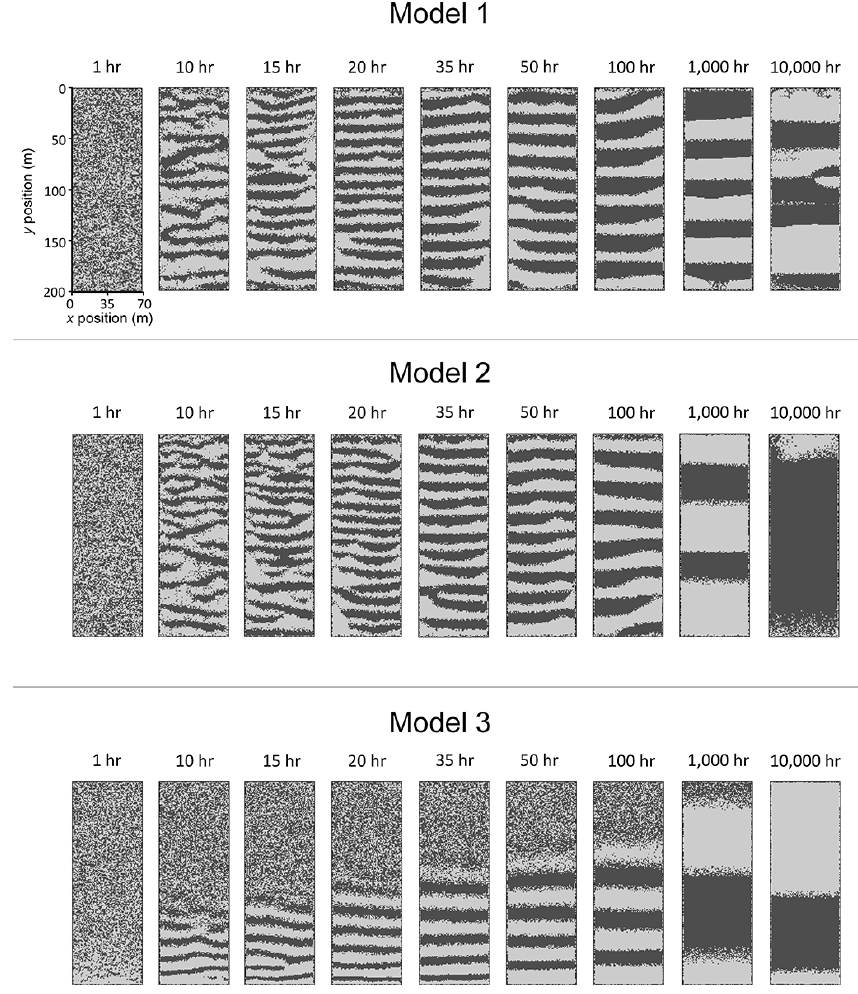
Figure 5. Final micro-habitat maps after 100 developmental steps, showing e ff ects of increasing ∆ t e on patterning in typical simulations with Model 1 (top panel), Model 2 (middle panel) and Model 3 (bottom panel). The value of ∆ t e assumed for each simulation is indicated immediately above the map. Light pixels represent hummocks, dark pixels represent hollows. Low values of y represent upslope locations ( y = 0 is the upslope boundary); high values of y represent downslope locations ( y = 200 is the downslope boundary); as such, groundwater flow is generally down the page. All maps have the same horizontal ( x , y ) scale as that shown for the upper-leftmost